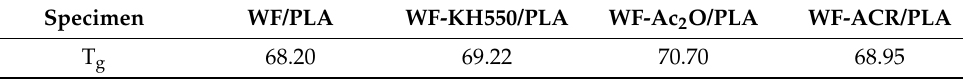
Table 2. Tg of unmodified and modified PLA/WF composites (Frequency: 5 Hz). Specimen